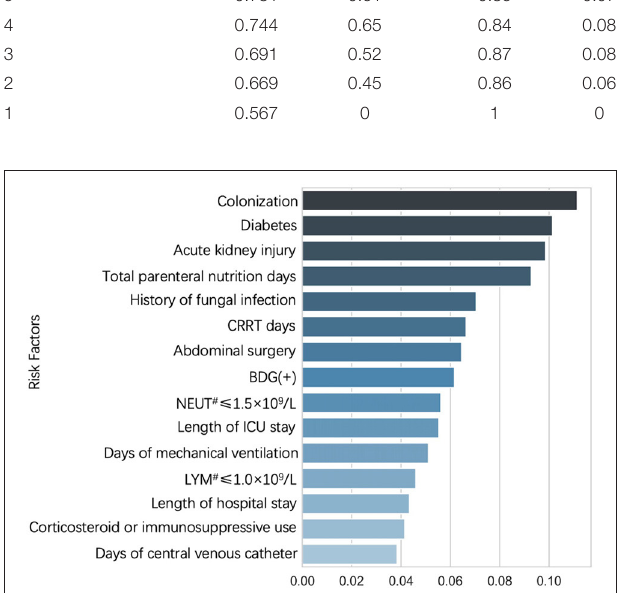
XGBoost achieved the best performance with a sensitivity of 84%, a specificity of 89% and a negative predictive value of